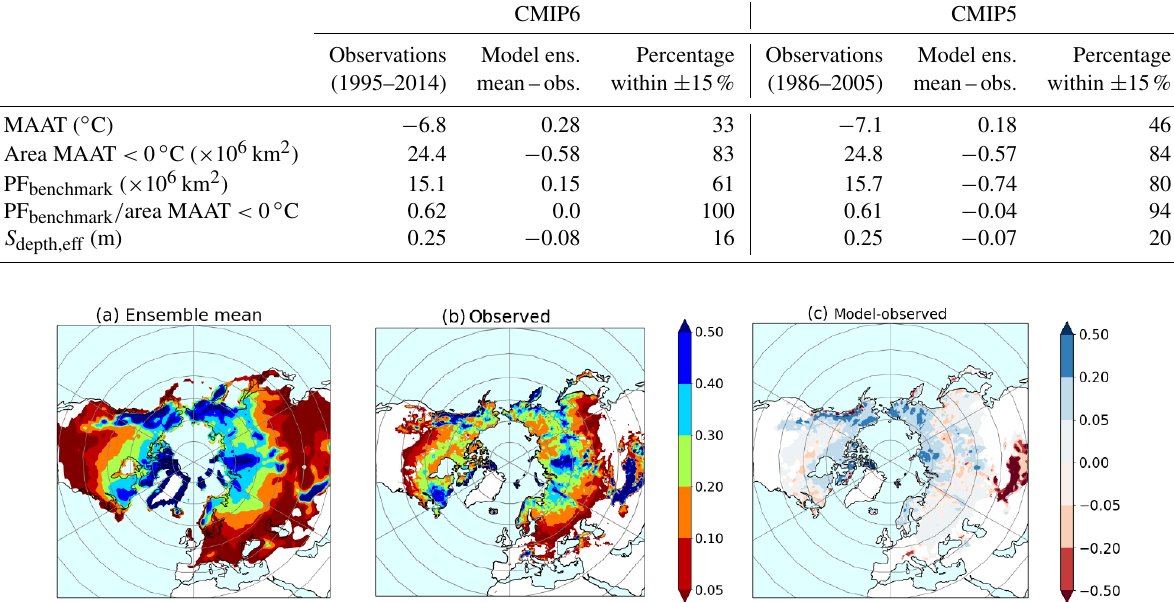
Table 3. A summary of the CMIP6 climate evaluation metrics compared with both the observations and CMIP5. Where relevant, statistics are given for PF aff defined by CCI-PF (Table 2). The difference between the multi-model ensemble mean and the observations are shown plus the percentage of the multi-model ensemble within ± 15% of the observations. It should be noted that the observed S depth,eff is for the period 1998–2016.